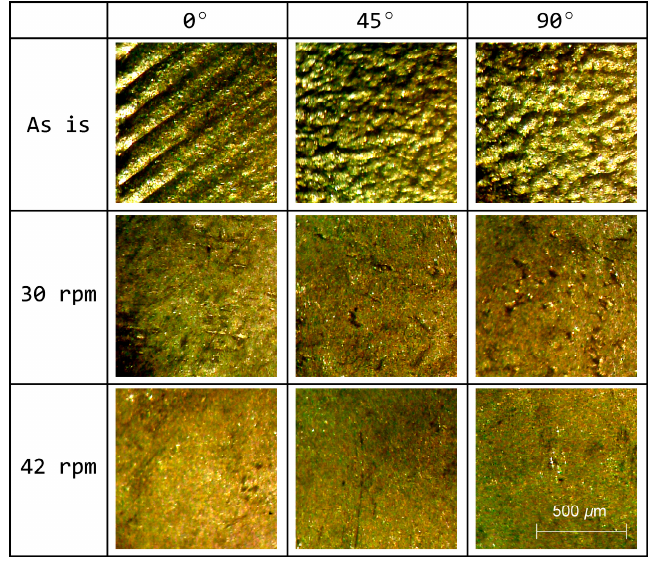
Figure 6. Macrographies before and after barrel finishing (BF).